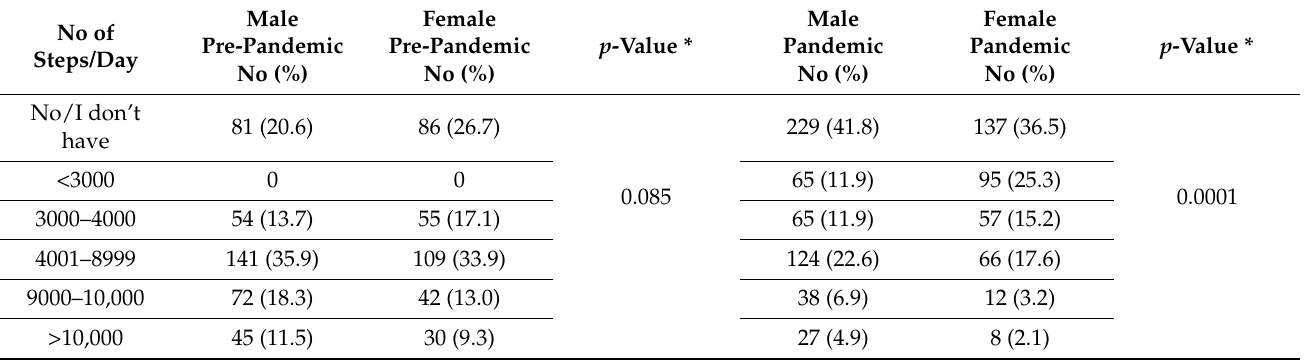
Table 8. Number of steps per day, (for those who have a smartwatch fitness